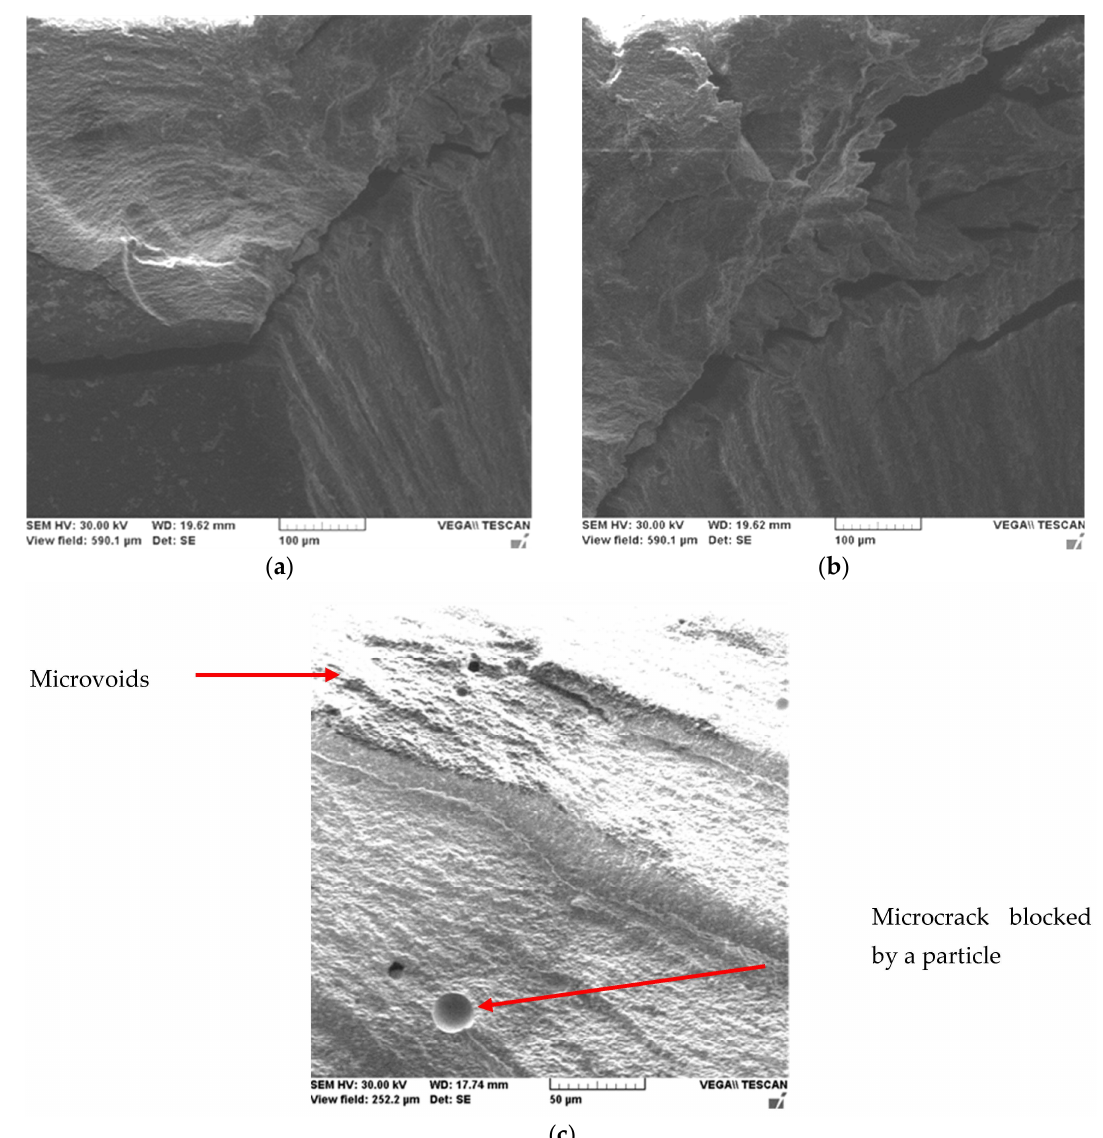
Figure 5. SEM microscopy of the Filtek Z250—1 sample at various magnifications 500× ( a , b ), 1150× ( c ) showing some micro voids resulting from the pulling out of the filler particles.